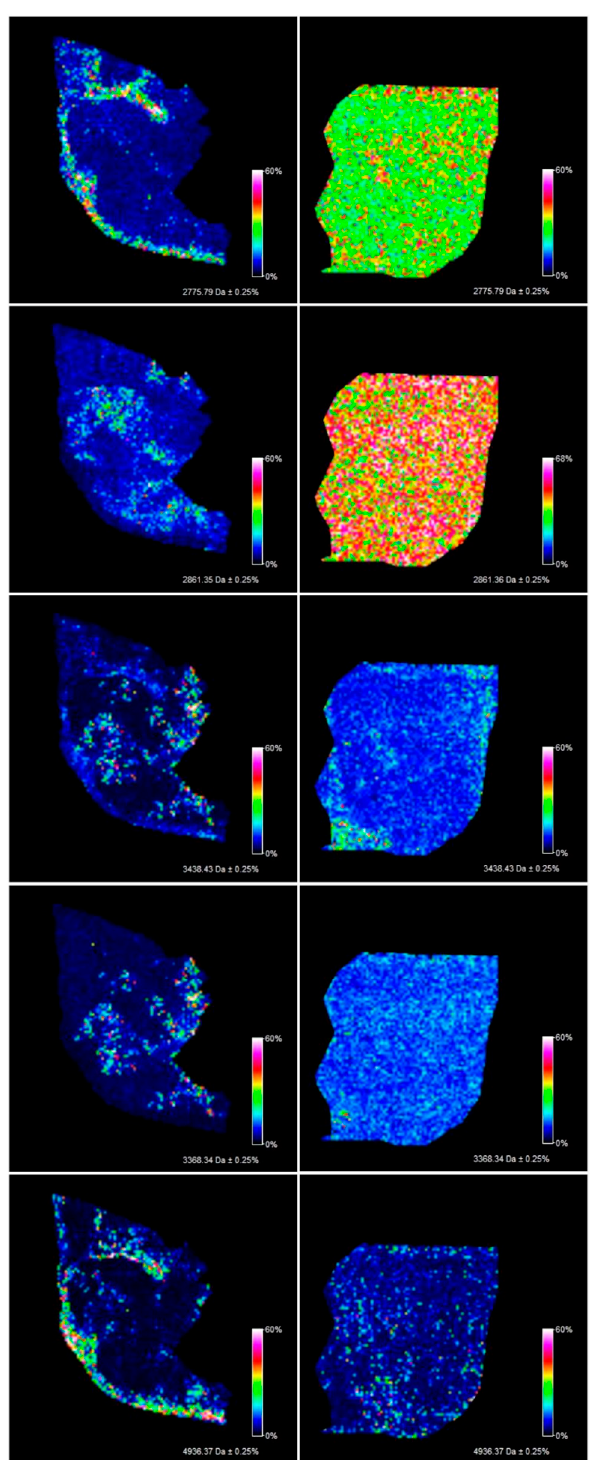
Figure 2. Pictures visualize the homogenous distribution of the regiospecific compounds from the borderline ovarian tumor tissue section (left) in the fibrothecoma tissue section (right).